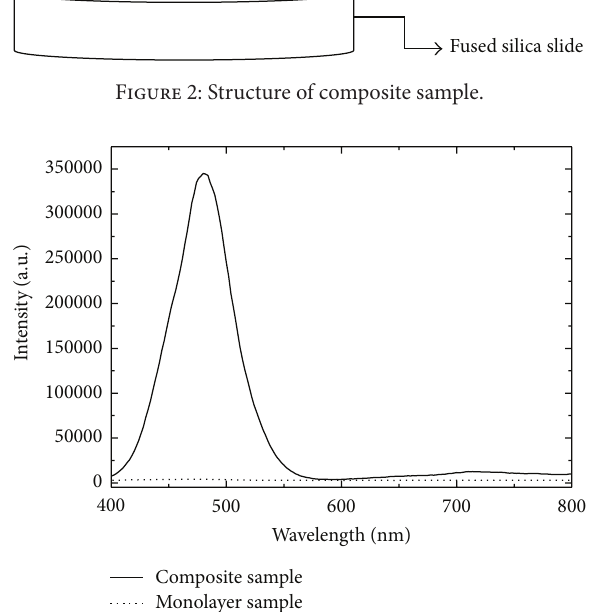
Figure3:Photoluminescenceemissionspectraofcompositesample (straight line) and monolayer sample (dotted line) at 190nm.